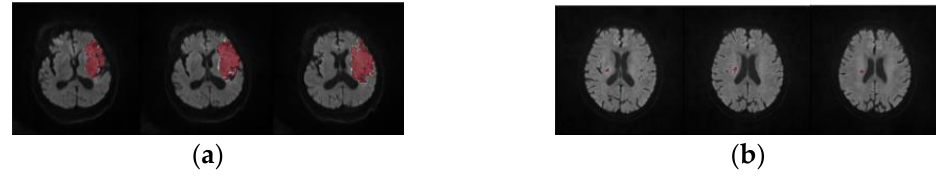
Figure 1. Example of ( a ) large-sized AIS on DWI and ( b ) small-sized AIS on DWI .